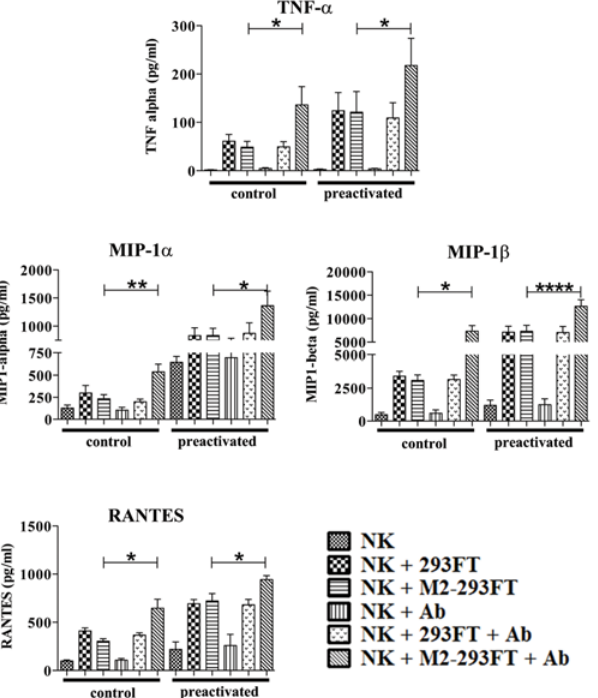
Fig 5. Cytokine release by cytokine-preactivated NK cells in the presence of Ab1-10 mAb. Control (cultured with low concentrations of IL-15) NK cells and cytokine-preactivated (pretreated with IL-12, IL-15 and IL-18) NK cells were co-cultured with both 293FT cells and M2-293FT cells in the presence and absence of Ab1-10 mAb (Ab). The cell culture supernatants were harvested and subjected to cytometric bead analysis for cytokine release measurements. The values on the y-axis correspond to the concentrations of TNF- α , MIP-1 α , MIP-1 β and RANTES in pg/ml. Graph bars represent the average ± SEM. Data shown are from independent experiments five independent experiments with NK cells from five donors ( * P < 0.05, ** P < 0.01 **** P <